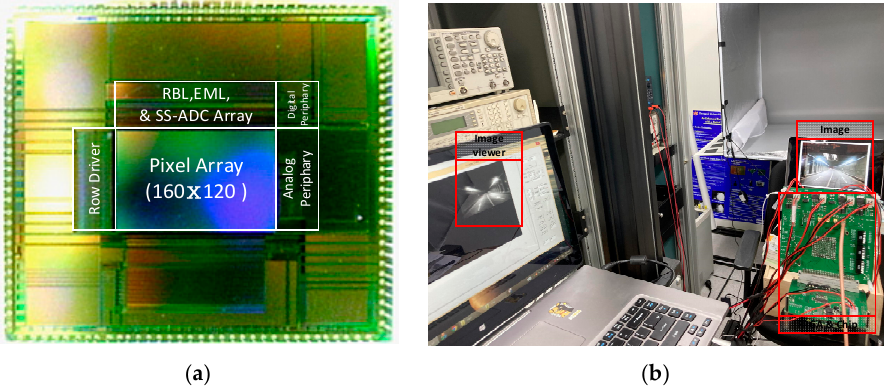
Figure 9. ( a ) Chip microphotograph and ( b ) measurement environment.